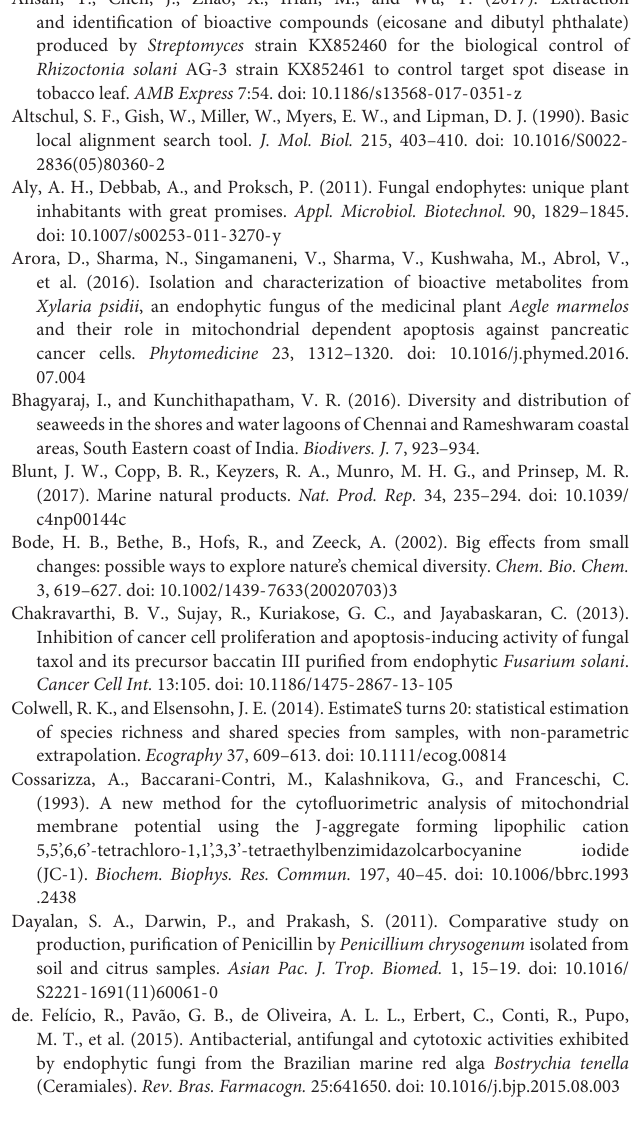
Supplementary Table 1 | Composition of different media used in this study (all media mentioned below are without agar served as broth media). Supplementary Table 2 | Species richness and diversity indices of marine endophytic fungi obtained from green, brown, and red algae. Supplementary Table 3 | The 50% cytotoxic concentration (CC 50 ) value of marine endophytic fungal extract against cancer cell lines HeLa, A431, and healthy cells (HEK). Supplementary Table 4 | (A) Thin-layer chromatography band character and retention factor ( R f ) value of the mycelia extract of B. petrensis . (B) Thin-layer